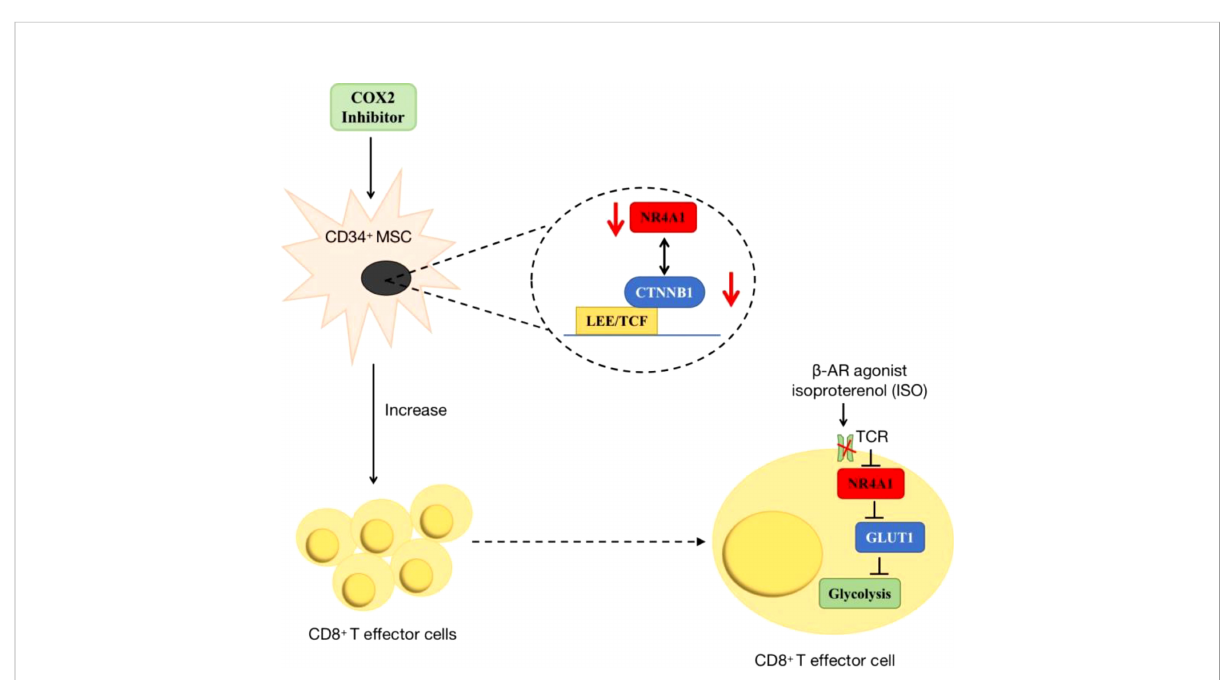
FIGURE 7 The roles of NR4A1 in regulating T cell. In AML, the inhibition of COX2/NR4A1/CTNNB1 signaling pathway can increase the produce of CD8+ T cell to rescue anti-cancer immunity. In melanoma, b -AR agonist inhibits NR4A1 and its downstream glycolysis to mediate CD8+T cell